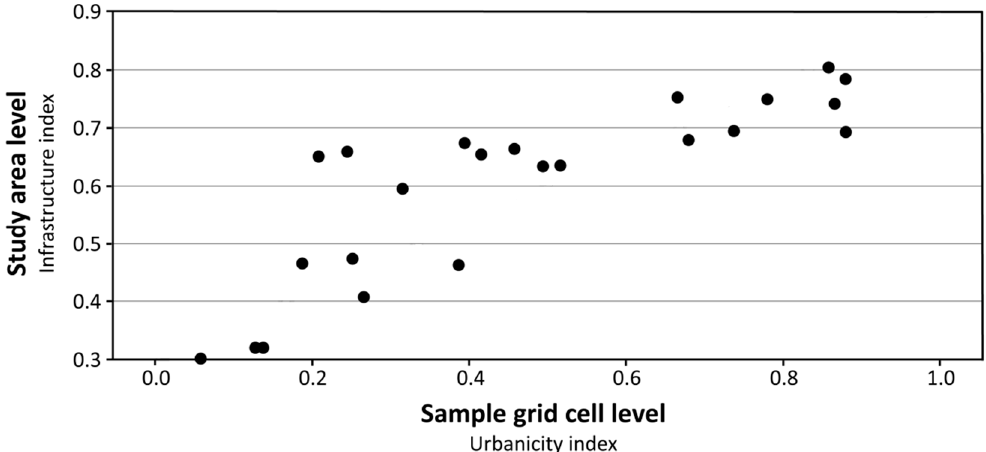
Figure 12. Correlation between urbanicity and infrastructure index values (r = 0.8, significant at 0.01 level).